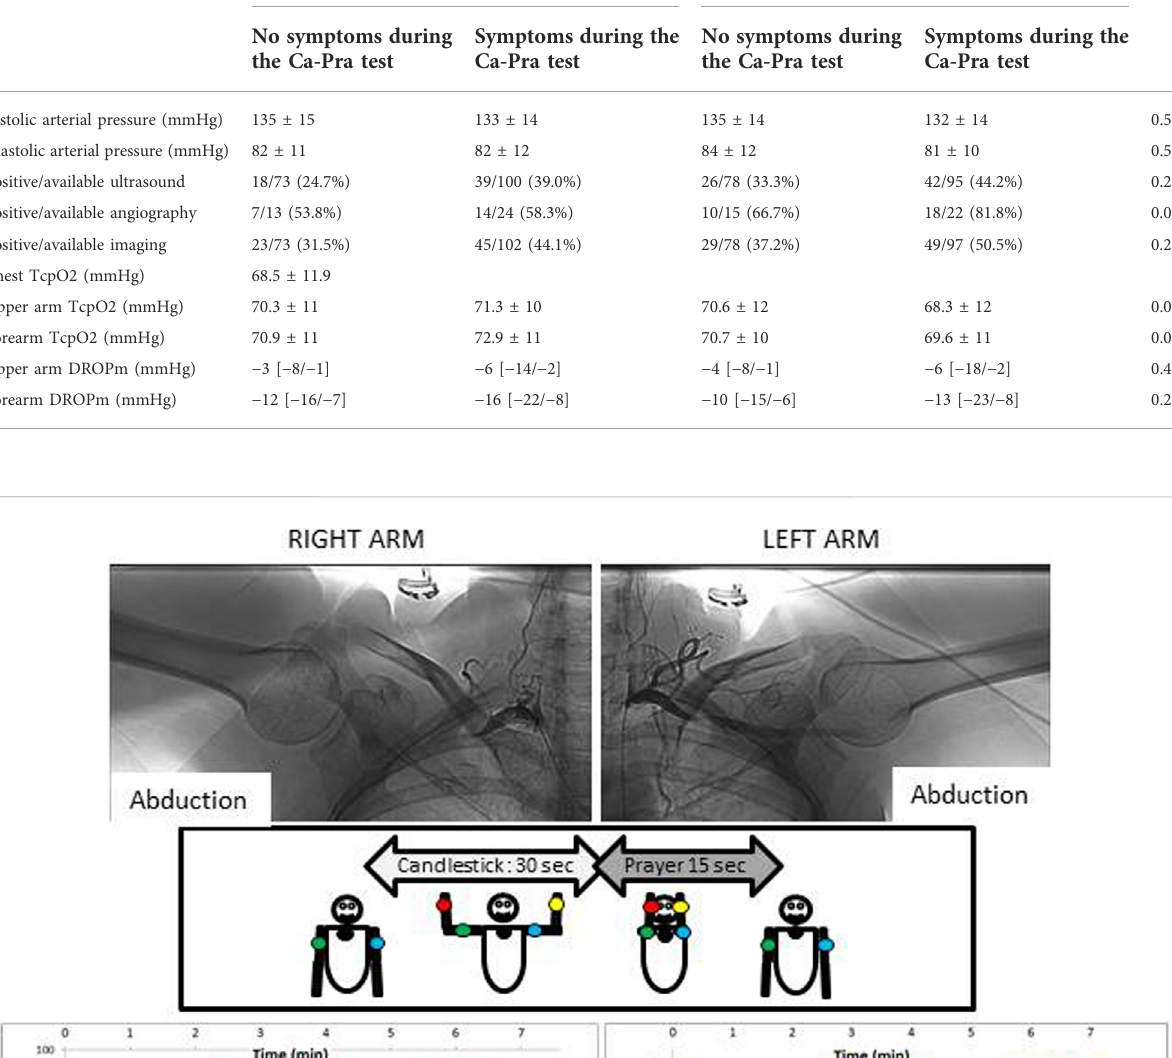
TABLE 1 Results of investigations among the studied patients. Positive imaging is either positive ultrasound or positive angiography. p is the difference between right and left side regardless of the presence or absence of symptoms. Recorded parameter Right arm Left arm p No symptoms during Symptoms during the No symptoms during the Ca-Pra test Ca-Pra test the Ca-Pra test